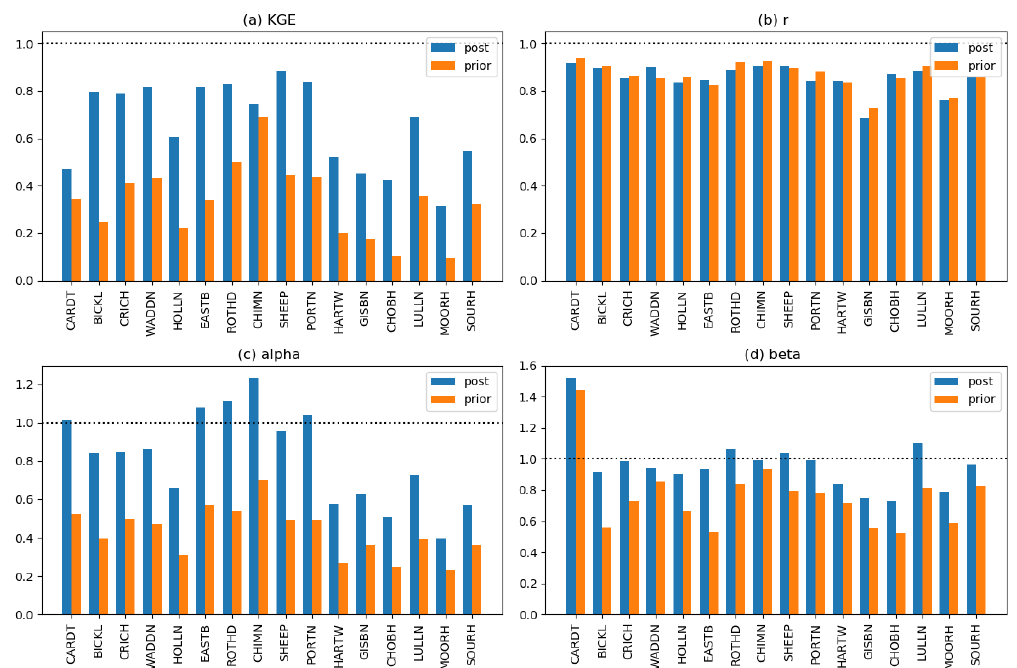
Figure 7. Kling–Gupta efficiency scores for JULES runs using prior and posterior PTF variable values. Horizontal dotted lines show the value of the metric for a perfect match between the model and observations.